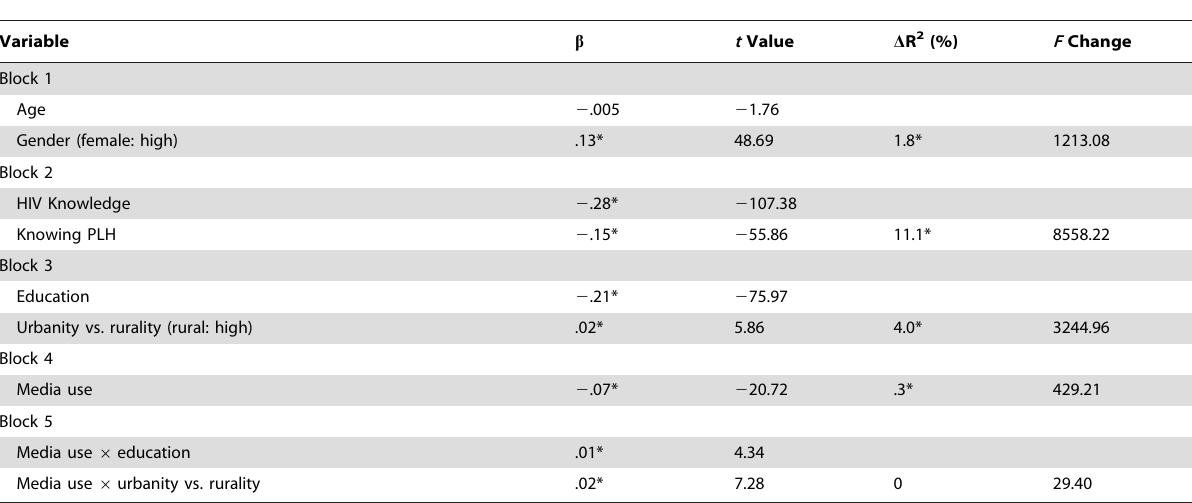
Table 3. Summary of results from the hierarchical regression analysis.